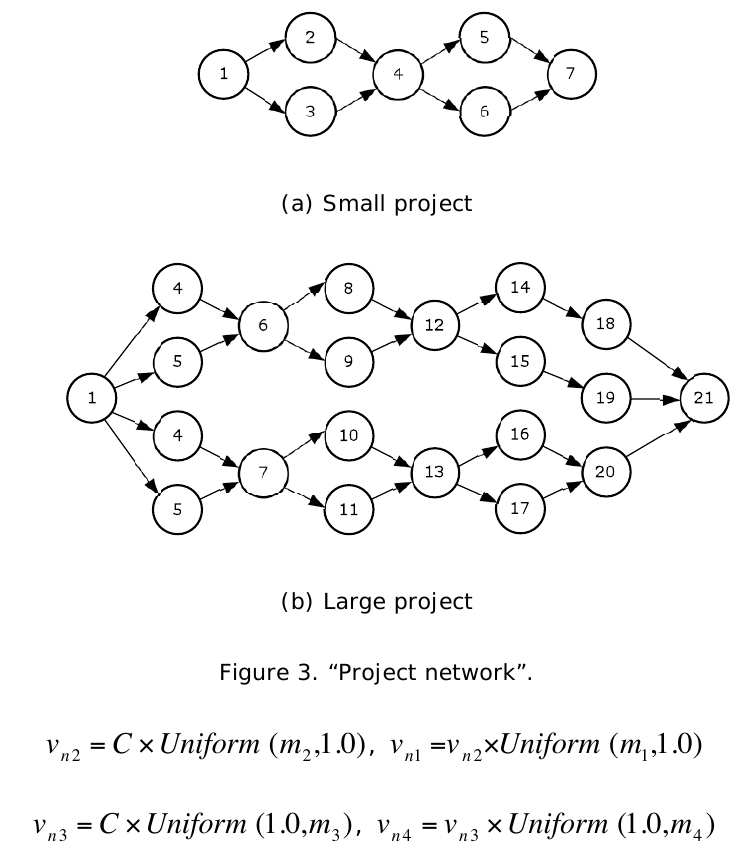
Figure 3. “Project